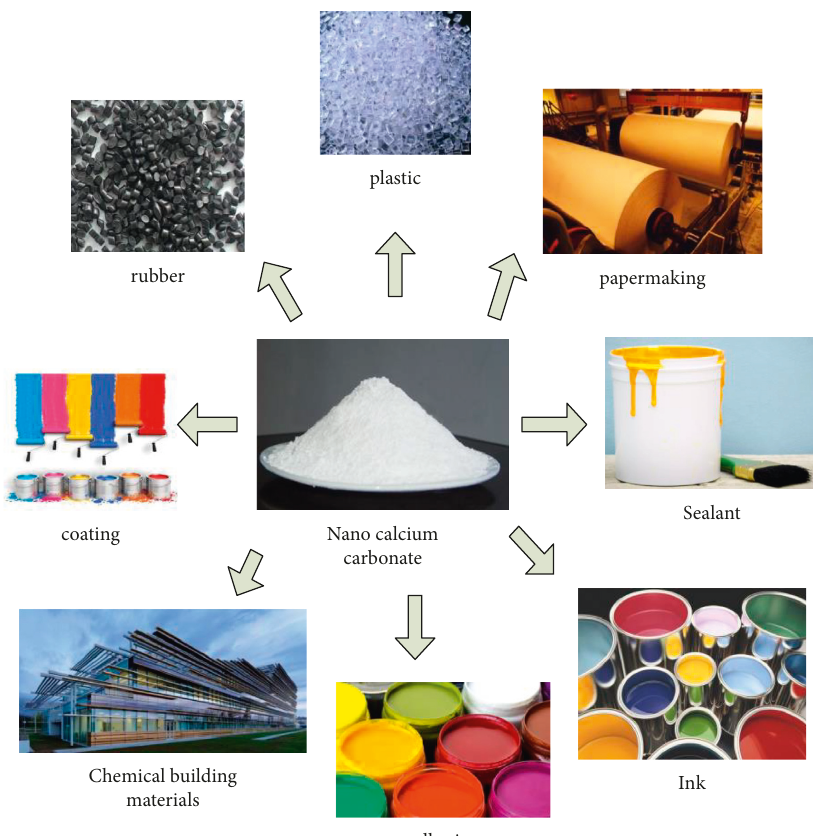
Figure 2: Application of nano-calcium